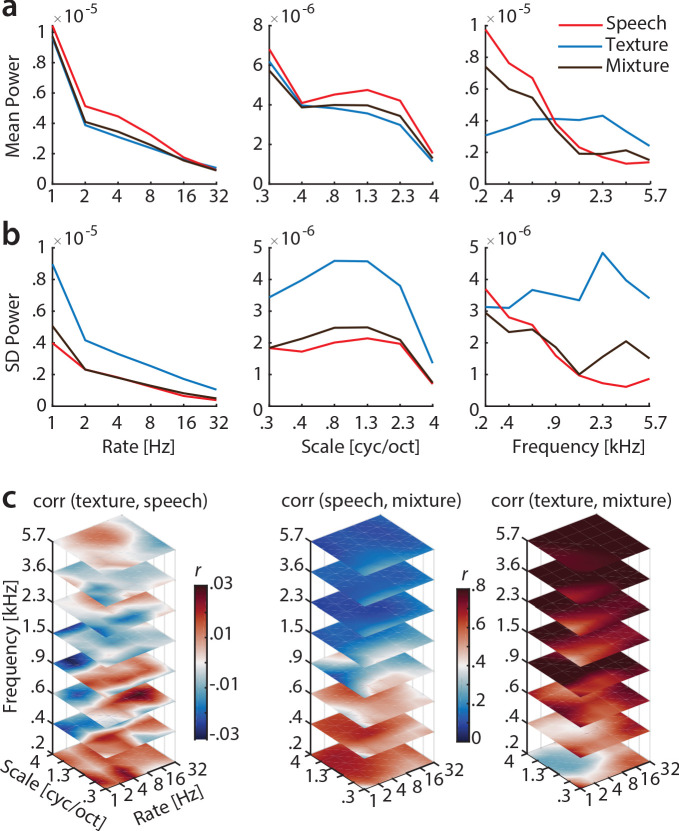
Modulation spectra of the stimuli.(a) Average of the marginalized modulation spectra for the stimulus streams separately and their mixture. (b) Standard deviation (SD) of the marginalized modulation spectra. (c) Pairwise correlations (Pearson’s r) between the different streams in the modulation representation. While speech and texture are mostly uncorrelated over time, the speech–texture mixture is highly correlated with the speech stream in the low frequency range and with textures in the high frequency range. Note that the left plot has a different scaling than the middle and right plot.